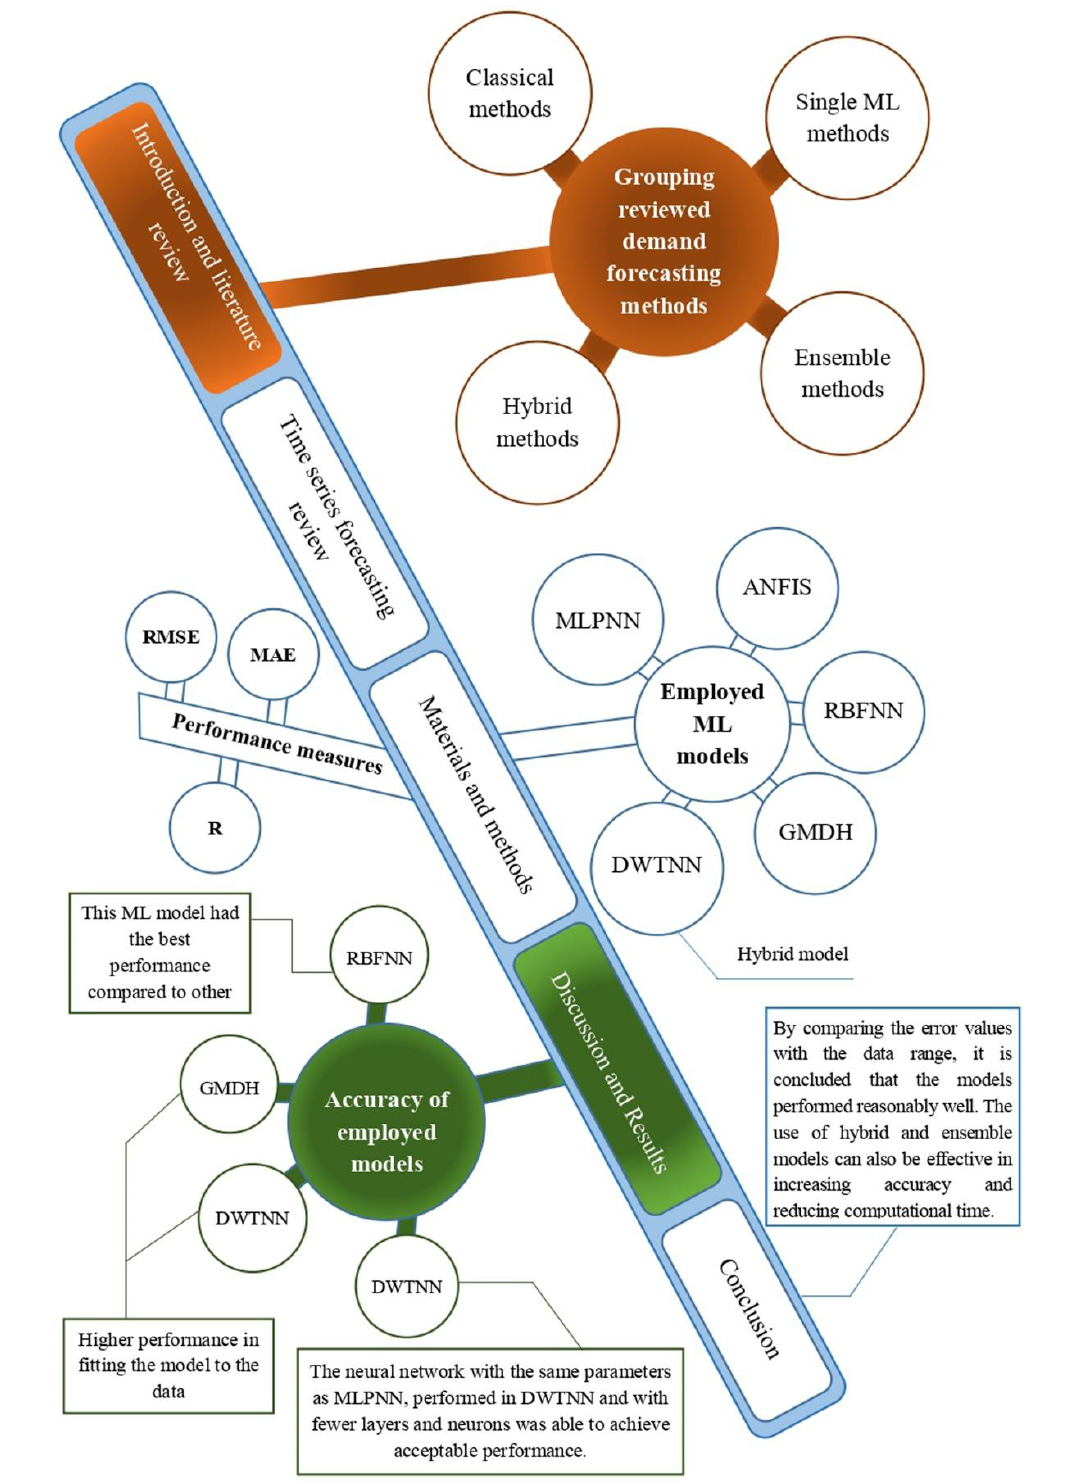
Fig. 1. Demonstration of the procedure utilized on this